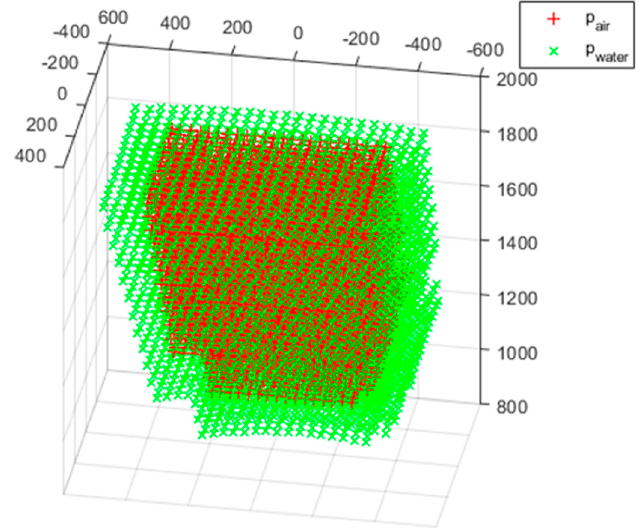
Figure 21. A pair of measurement